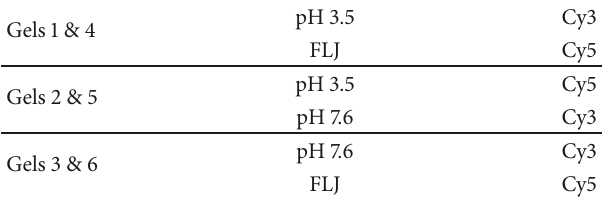
Table 1: Labelling of the samples with cyanidin dye fluorescent labels (NHS esters): Cy3 and Cy5 for 2D-DIGE. The gels were run in duplicate. Cy2 was used as the internal standard. Cells were treated with fermented lingonberry juice